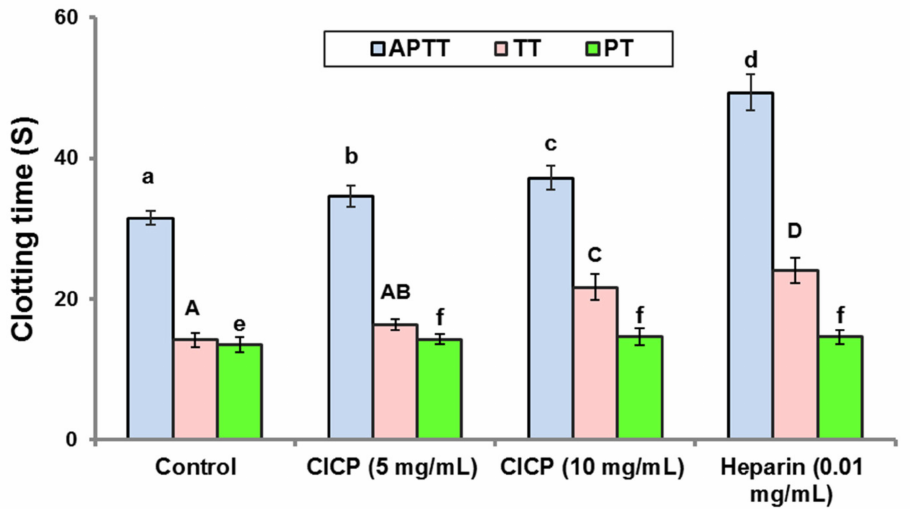
Figure 5. Anticoagulant activity of CICP. Results were expressed as mean ± SD ( n = 3). Mean values with different letters in each assay (APTT, a–d), (TT, A-D) and PT (e,f) show significant differences ( p < 0.05) between different